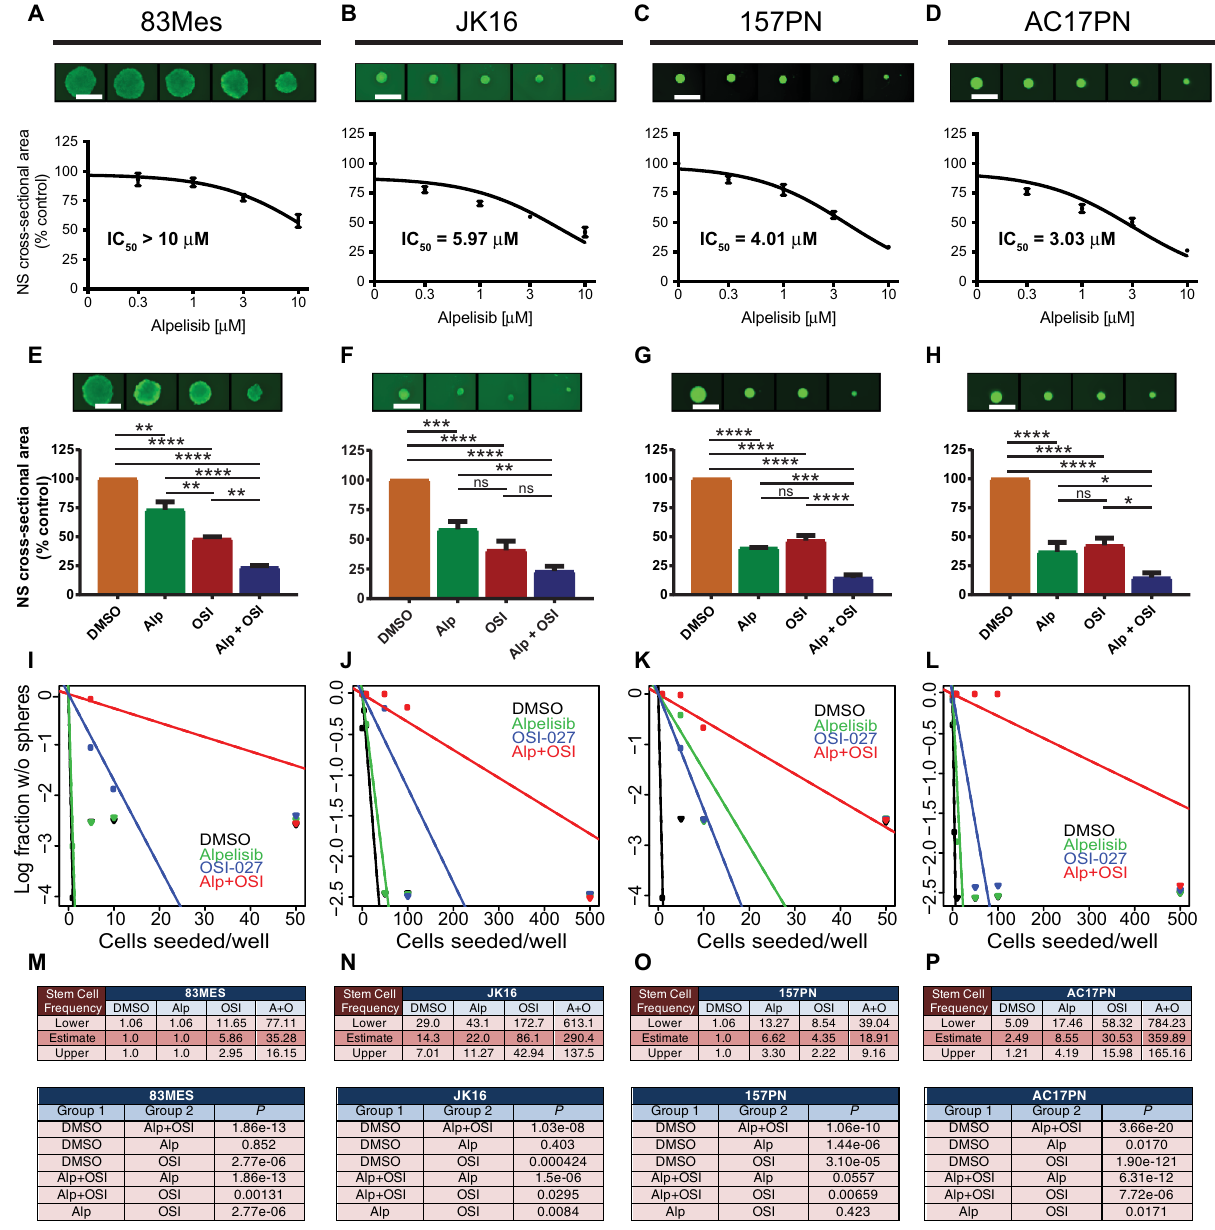
Figure 3. Effects of dual PI3Kα and mTOR inhibition in GSCs. ( A – D ) 83Mes ( A ), JK16 ( B ), 157PN ( C ), and AC17PN ( D ) GSC lines were seeded at 500 cells per well into round-bottom 96-well plates in the presence of increasing concentrations of alpelisib as indicated. After 7 days, spheres were stained with acridine orange and imaged on a Cytation3 instrument using Gen5 v 2.09 software to determine cross-sectional area. Prism GraphPad 8 was used to determine IC 50 values. Data represent means ± SEM of 4 (83Mes, JK16), or 3 (157PN, AC17PN) independent experiments, each done in triplicate. Representative images are shown in the top panels. ( E – H ) 83Mes ( E ), JK16 ( F ), 157PN ( G ), and AC17PN ( H ) GSC lines were seeded at 500 cells per well into round-bottom 96-well plates in the presence of alpelisib (5 µM) and/or OSI-027 (1 µM). After 7 days, spheres were stained with acridine orange and imaged to determine cross-sectional area. Data represent means ± SEM of 4 (83Mes, JK16), 3 (157PN), and 5 (AC17PN) independent experiments, each done in triplicate. Representative images are shown in the top panels. Unpaired one-way ANOVA, * p ≤ 0.05; ** p ≤ 0.01; *** p ≤ 0.001; **** p ≤ 0.0001. ( I - P ) GSCs were subjected to in vitro limiting dilution assays (n = 3, each done in duplicate) plating decreasing number of cells (500; 100; 50; 10; 5; 1 cells per well) in the presence of alpelisib (5 μM) and/or OSI-027 (1 μM). ELDA for 83Mes ( I , M ), JK16 ( J , N ), 157PN ( K , O ), and AC17PN ( L , P ) was done using the ELDA software (http://bioin f.wehi.edu.au/softw are/elda/). ( M - P , upper panels) Stem cell frequencies of GSCs were estimated as the ratio 1/ x with the upper and lower 95% confidence intervals, where 1 = stem cell and x = all cells. ( M - P , lower panels) P -values from chi-square analysis of group